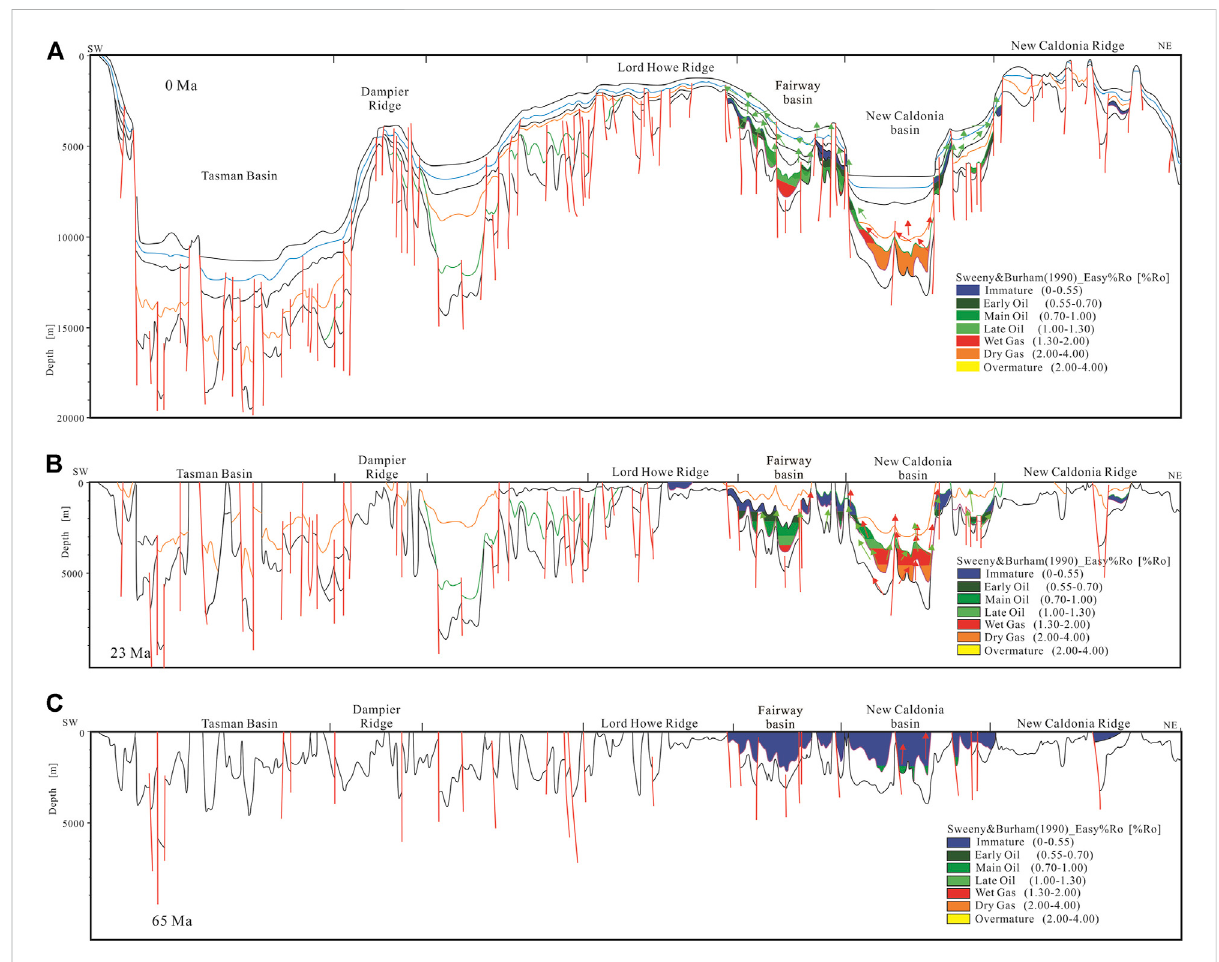
FIGURE 7 Large-section thermal history simulation pro fi le across Zealandia (line 206/04 from Van de (Beuque et al. 2003).